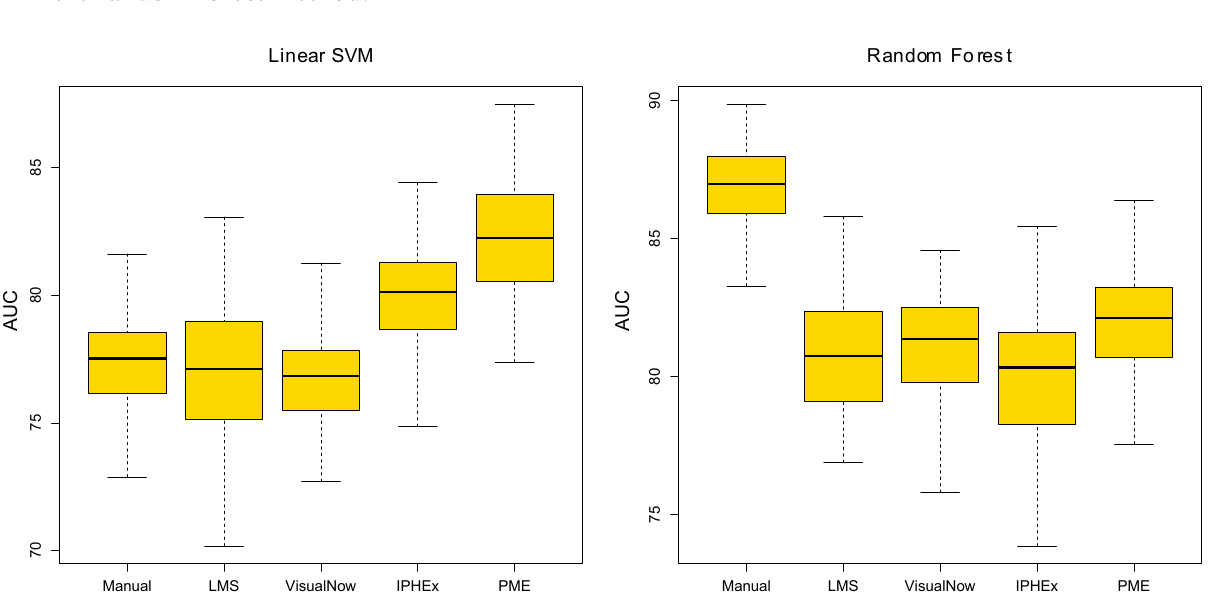
Figure 4. Boxplots of 100 runs of the ten-fold cross validation for both, the linear SVM and the random forest